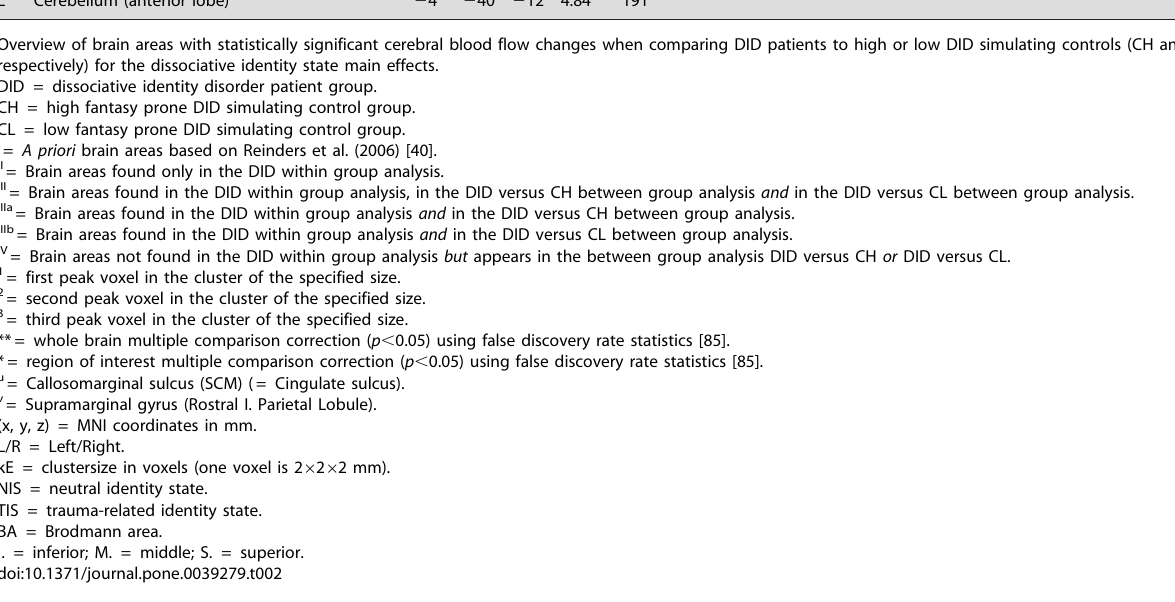
Withingroup Betweengroup DID only DID - CH DID - CL